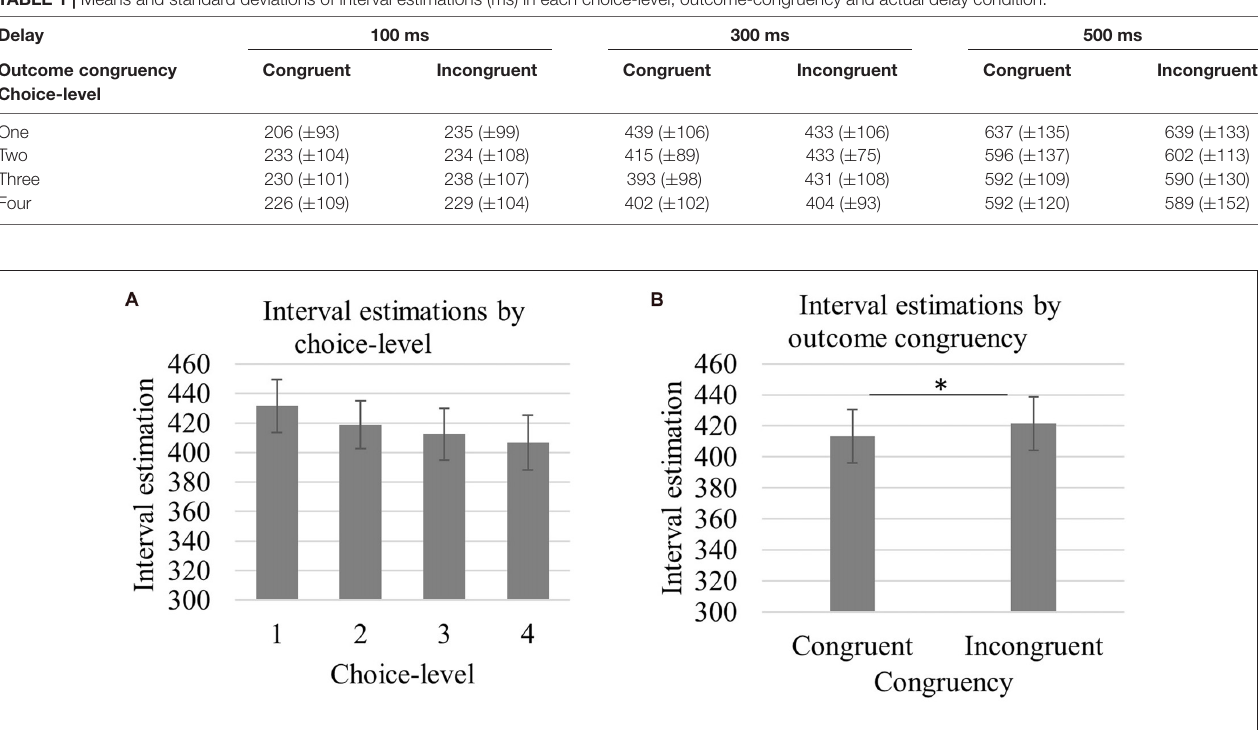
Table 1 . In order to examine the effects of choice-level and outcome congruency, we conducted a 4 × 2 × 3 repeated measures ANOVA with choice-level (one, two, three, four), congruency (congruent, incongruent) and delay (100 ms, 300 ms, 500 ms) as within-subjects factors. The analysis yielded significant main effects of choice-level ( F ( 3,63 ) =